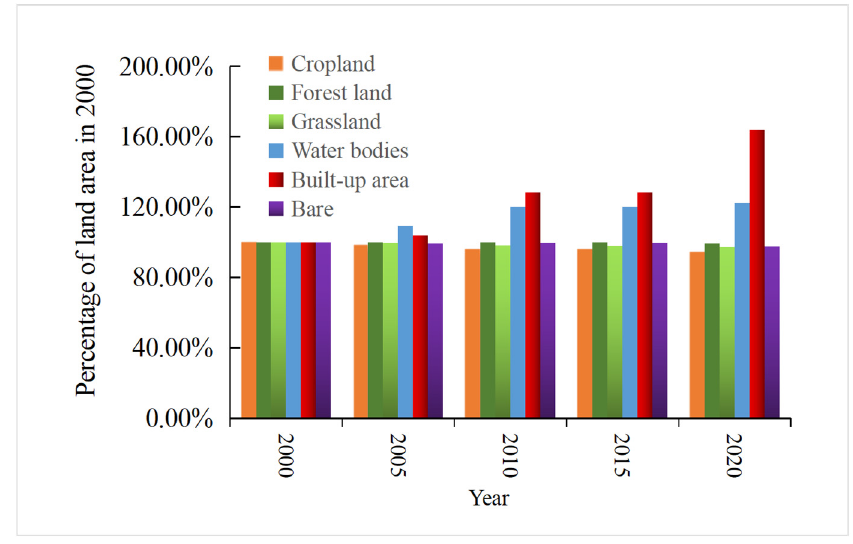
Figure 5. Changes in land cover in western Hubei Province from 2000 to 2020 (Note: The area of each land cover type in 2000 is used as the standard.).